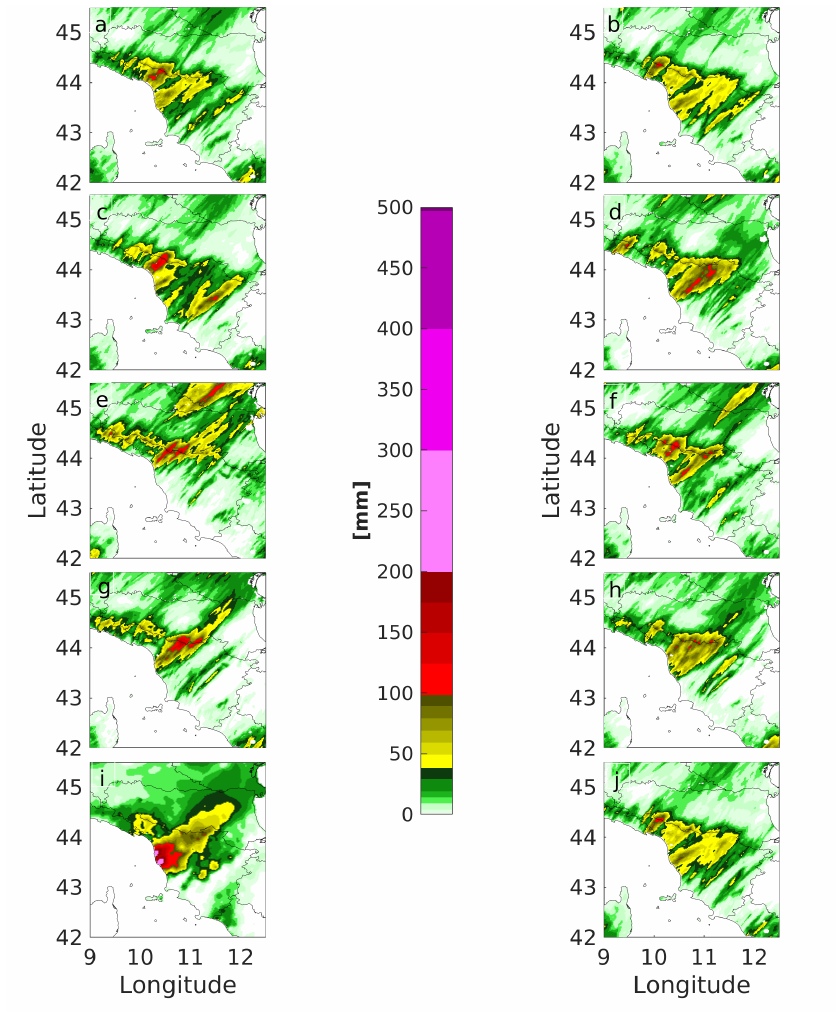
Figure 9. IFS-driven cases. QPF values for the 12 h time period from 18UTC on 9 September 2017 to 06UTC on 10 September 2017, where ( a ) = LST, ( b ) = SST, ( c ) = SM, ( d ) = WIND, ( e ) = ZTD_GNSS3h, ( f ) = ZTD_GNSS3h_1ist, ( g ) = WIND+SM+ZTD_GNSS3h_1ist, ( h ) = WIND+SM+ZTD_GNSS3h_1ist_18UTC (only 18UTC), ( i ) = OBS, ( j ) = OL. For details about the 3DVAR approaches the reader is referred to the main